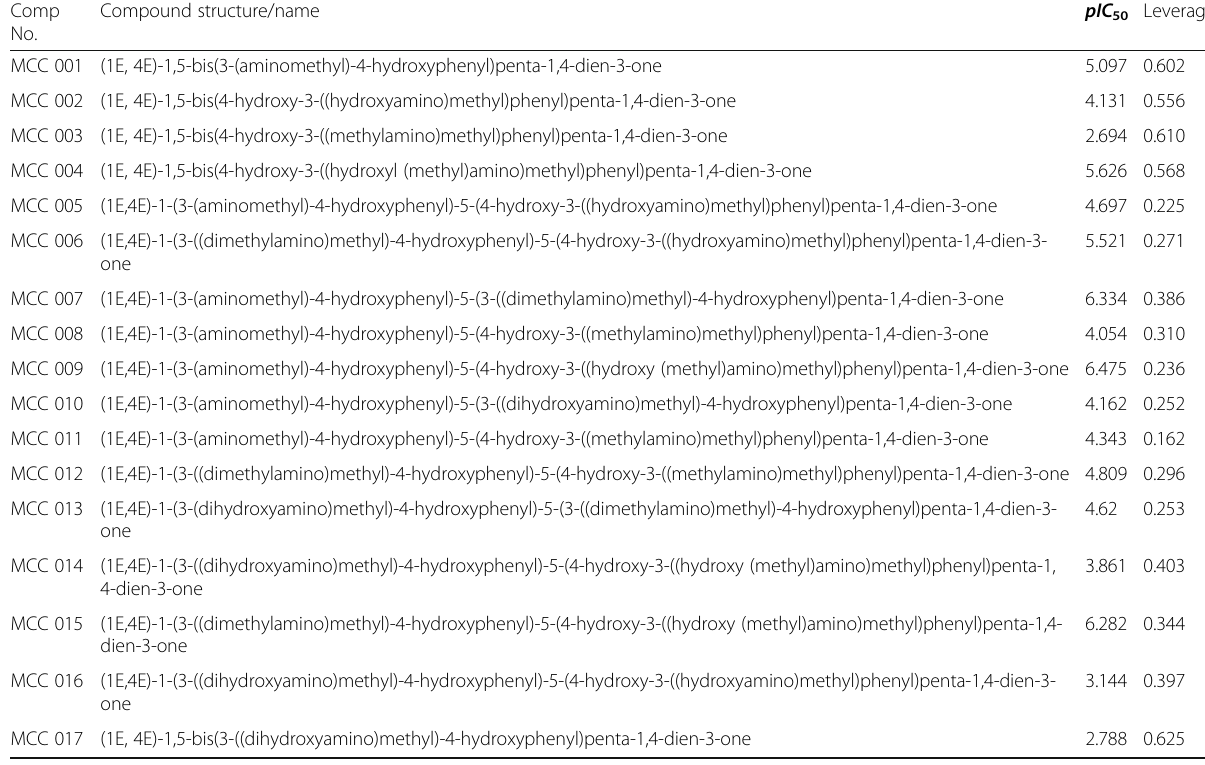
Table 1 Designed curcumin derivatives, their predicted antioxidant activities, and leverage values Comp